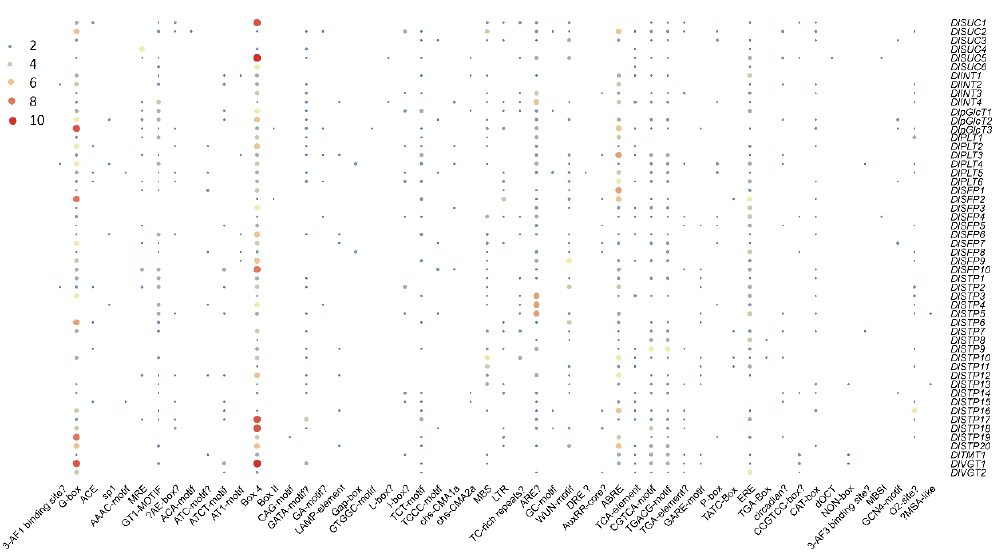
Figure 5. Heat map of the number of cis -elements in DlSTs promoter. Color bars and circle sizes indicate the number of cis- elements.